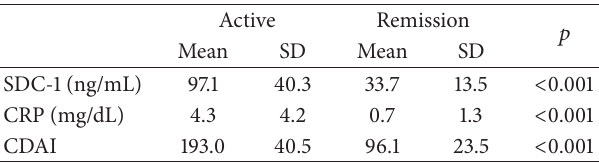
Table 3: Comparison of serum SDC-1 and CRP levels according to the disease activity.